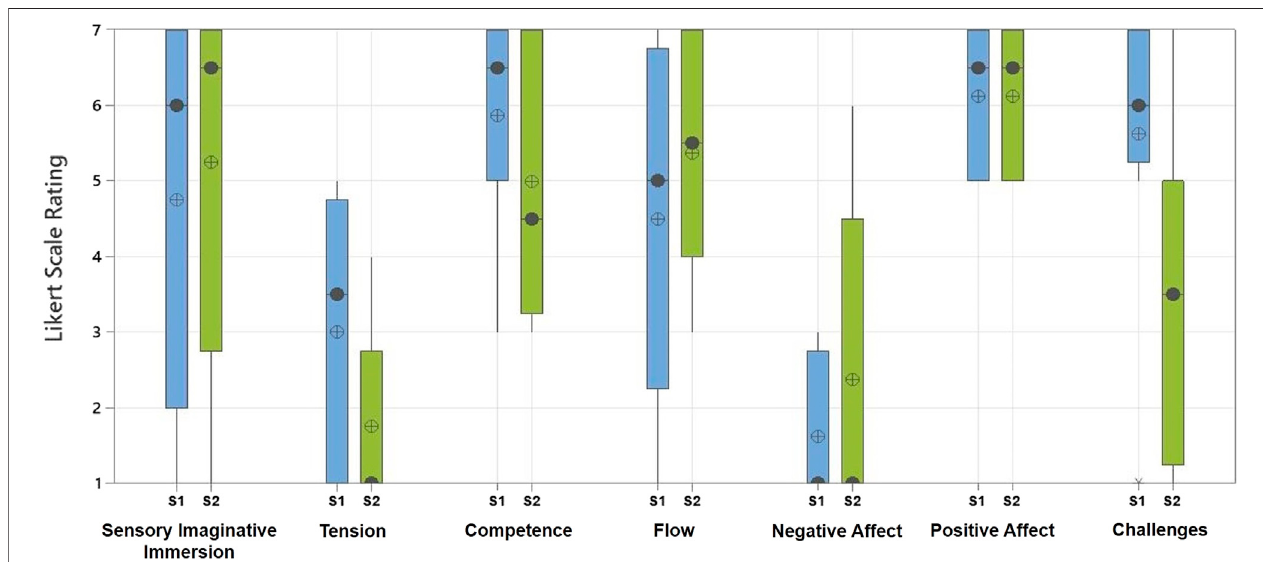
FIGURE 6 | The ratings of the participants of each statements in every component of the GEQ post-study as part of post-study questionnaire. The statements for each component are shown in Table 5 .